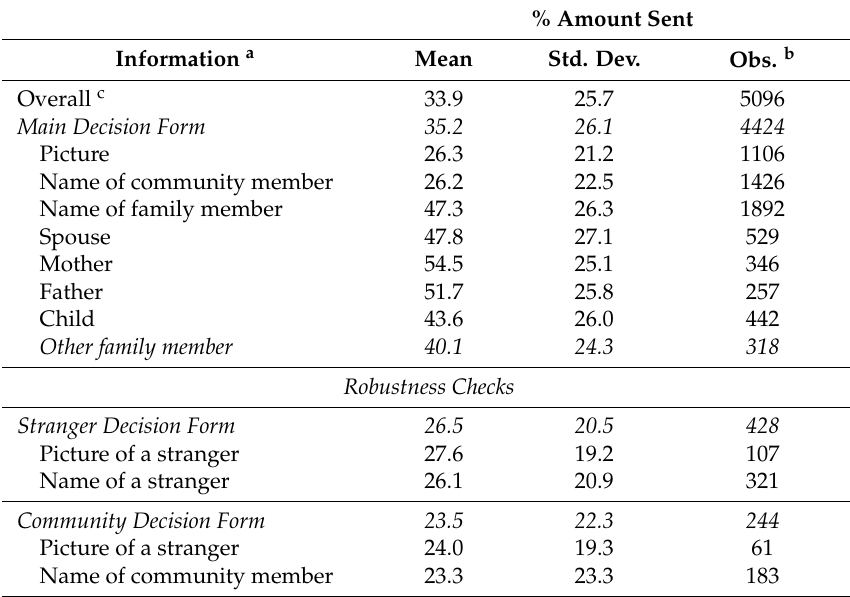
Table 1. Summary of comparative dictator donations, by recipient characteristic.